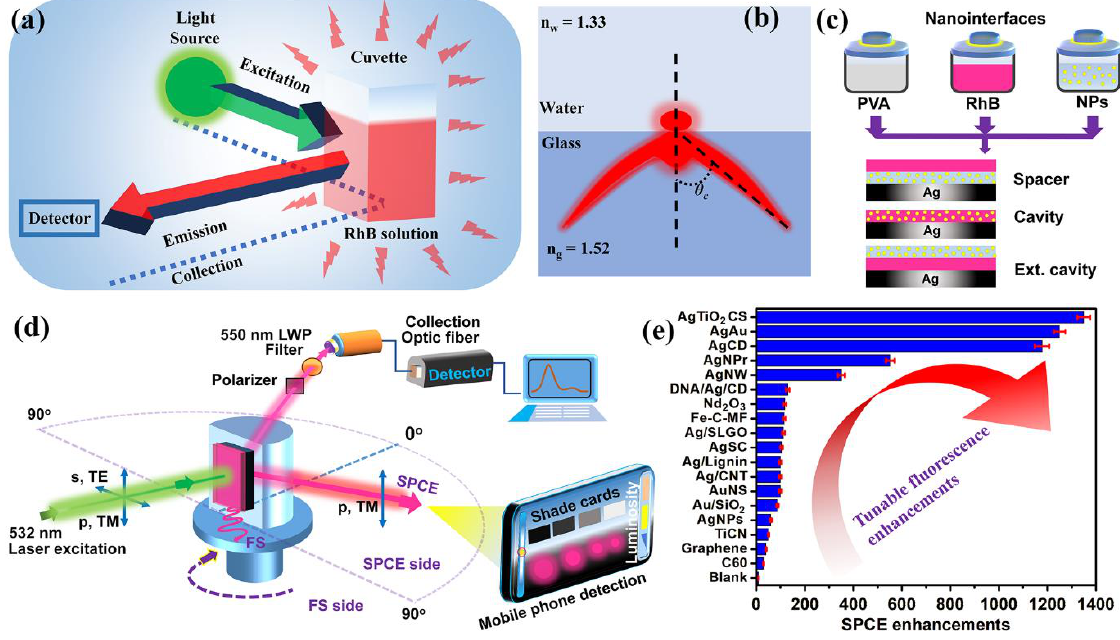
Figure 1. Conceptual schematic of ( a ) fluorescence emission (of RhB) recorded by conventional fluorescence spectrophotometer, ( b ) the angular dispersion of fluorescence emission as observed in the water-glass interface. The angle shown is critical angle ( θ C ) of emission. Adapted with permission from [11]. ( c ) Schematic of the spacer, cavity and ext. cavity nanointerfaces. ( d ) Optical setup used for SPCE experimental work with reverse Kretschmann (RK) configuration. The detection system is carried out using the conventional Ocean Optics detector, as well as the mobile phone-based detection system. Adapted with permission from [64]. ( e ) Tunable enhancements in the fluorescence enhancements observed using different nanomaterials and nanohybrids in SPCE platform. (Acronyms: AgTiO 2 CS: silver titanium dioxide cryosoret; AgAu: silver-gold nanohybrid; AgCD: silver NP decorated-carbon dots; AgNPrs: silver nanoprisms; AgNW: silver nanowire; DNA/Ag/CD: DNA based AgCD composite; Nd 2 O 3 : neodymium (III) oxide; Ag/SLGO: silver NPs decorated on single layer graphene oxide; Ag/lignin: lignin-based AgNPs; Ag/CNT: carbon nanotubes decorated with AgNPs; AuNS: gold nanostars; Au/SiO 2 : gold NPs decorated on silica NPs; TiCN: titanium carbonitride; C60: carbon allotrope or buckminsterfullerene, (C60-Ih) [5, 6] fullerene). While the spacer and ext. cavity nanointerfaces, as observed in Figure 1c, are consti-